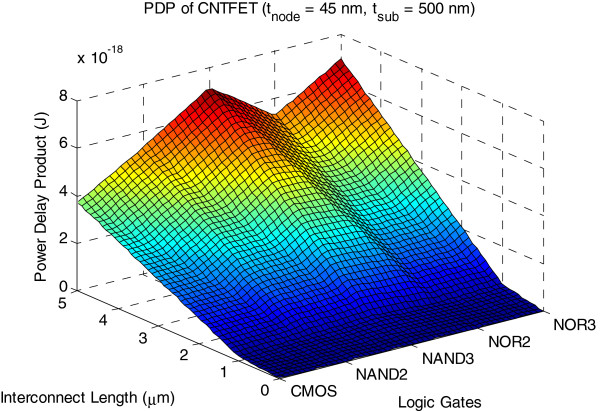
3D plot of PDP of CNTFET logic gates. The copper interconnect length is up to 5 μm for tnode = 45 nm and tsub = 500 nm.